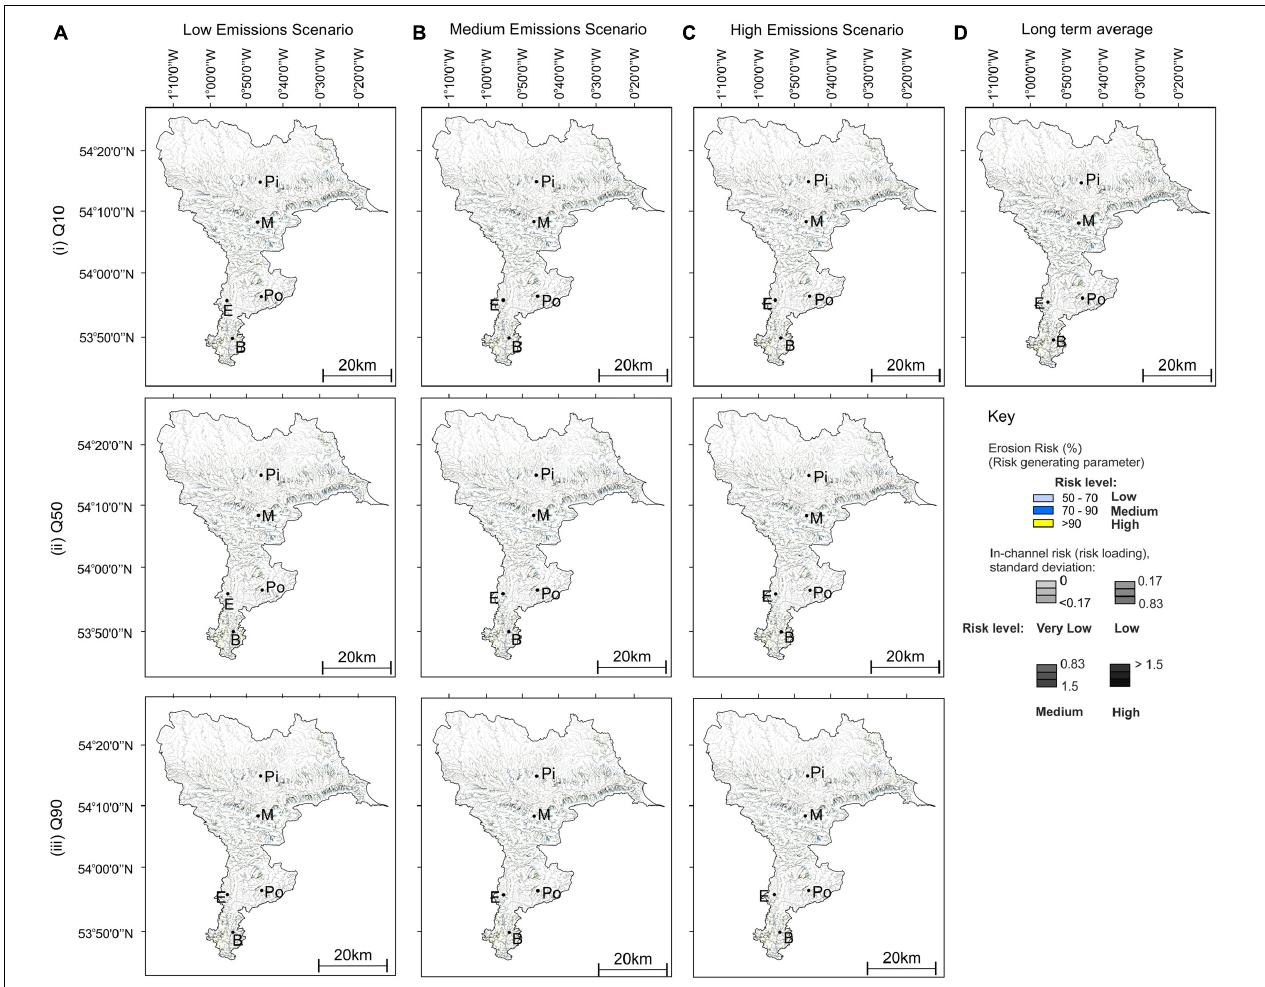
FIGURE 9 | Model scenario outputs for climate change scenarios in February, depicting (A) Low, (B) medium and (C) high emission scenarios, for the following quartiles: (i) Q10; (ii) Q50 and (iii) Q90 using UCKCP09 data (D) the long term average. Locations are shown on each map; Pi, Pickering; M, Malton; Po, Pocklington; E, Elvington; B,